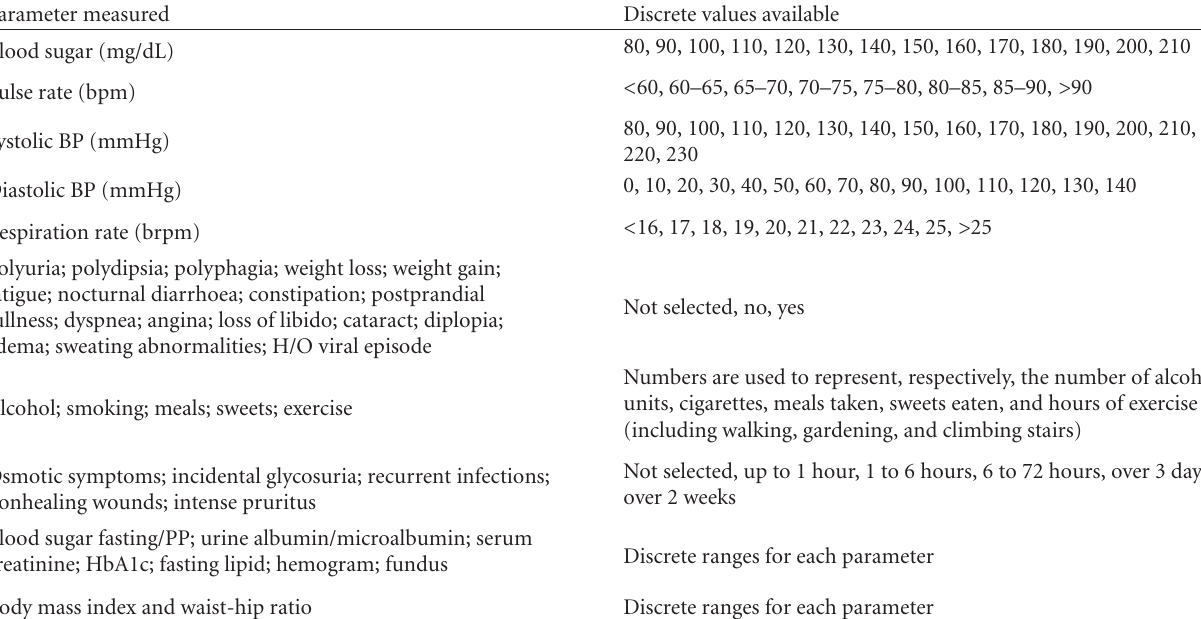
Table 3: Patient spreadsheet measurements for diabetic